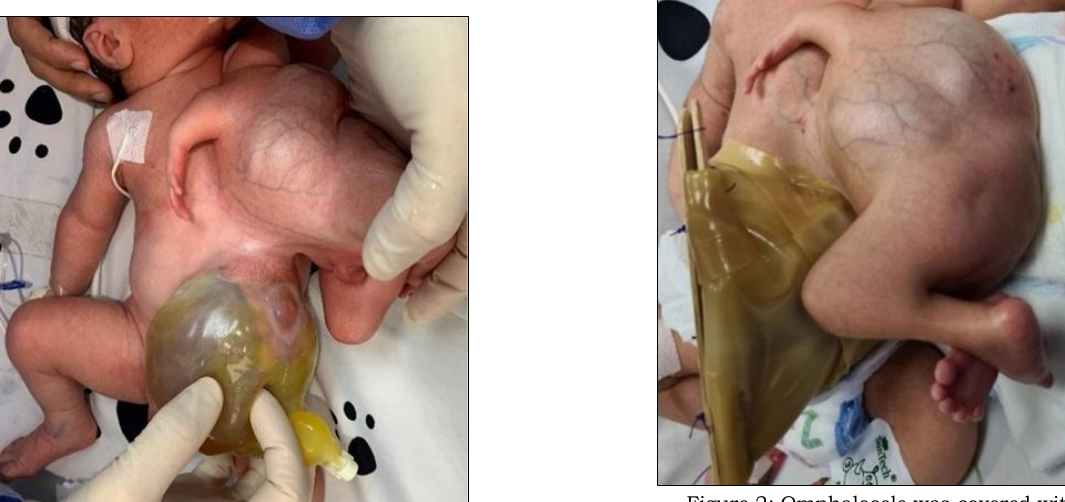
Figure 2: Omphalocele was covered with a temporary